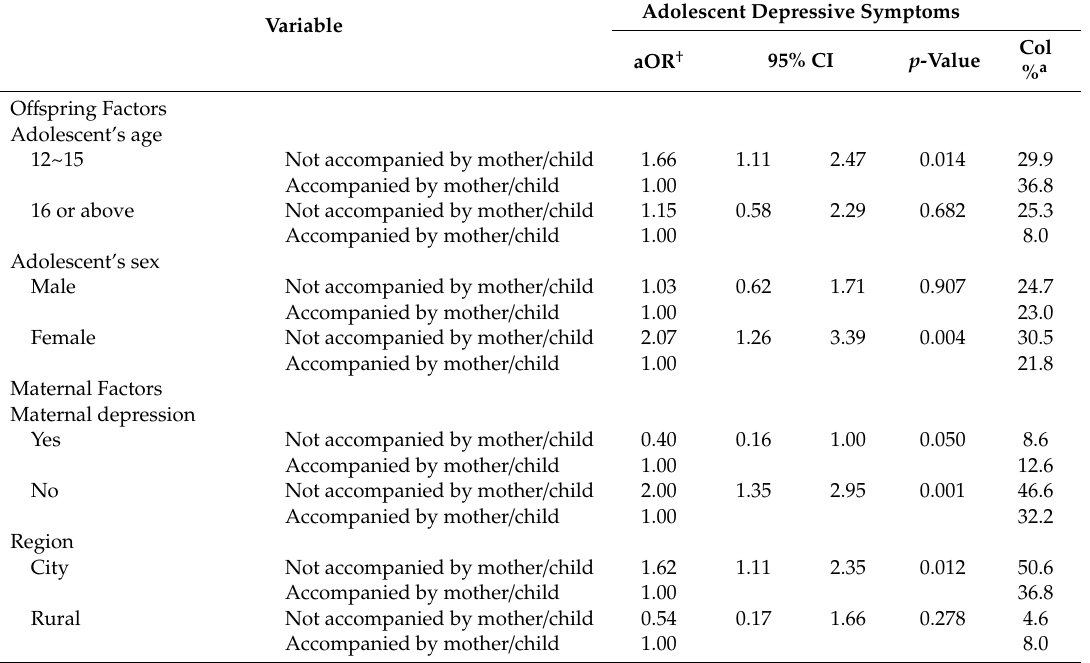
Table 3. Result of subgroup analysis of the association between maternal accompaniment at family dinners and depressive symptoms by adolescent’s sex, adolescent’s age, maternal depressive symptoms, and region. Adolescent Depressive Symptoms Variable aOR